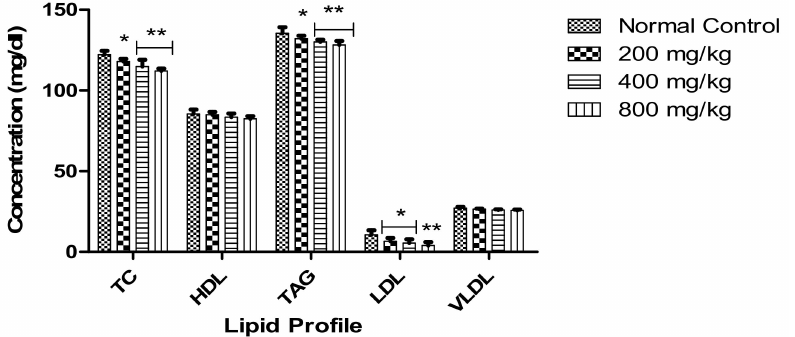
Figure 5. Effect of aqueous C. pepo leaf extract on lipid profile of male rats. Values represent the mean ± SD for n = 6. * indicates significance at ( p < 0.05) and ** indicates significance at p < 0.01. TC Total Cholesterol; HDL-C, High-Density Lipoprotein Cholesterol; TAG, Triglyceride; LDL-C, Low-Density Lipoprotein Cholesterol; and VLDL-C, Very Low-Density Lipoprotein